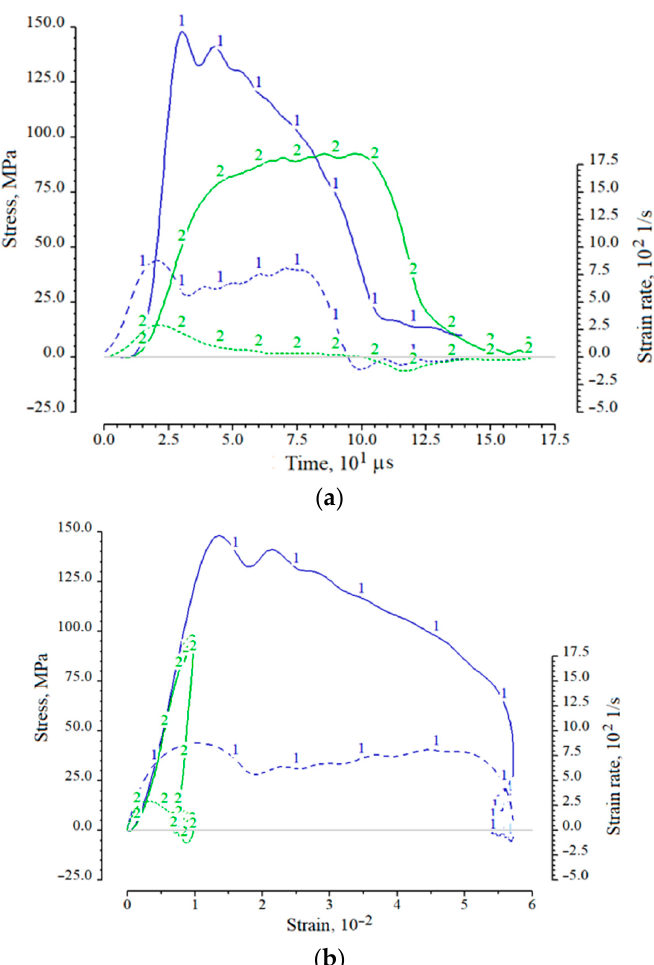
. ε . ε εε  ε  ( a ) and σ ( t ) and )( t ( ε ) and )( ss ( b ) for cases of main- s ( t ) ( a ) and σ s ( ε s ) and s ( ε s ) ( b ) for cases of maintaining s s s s